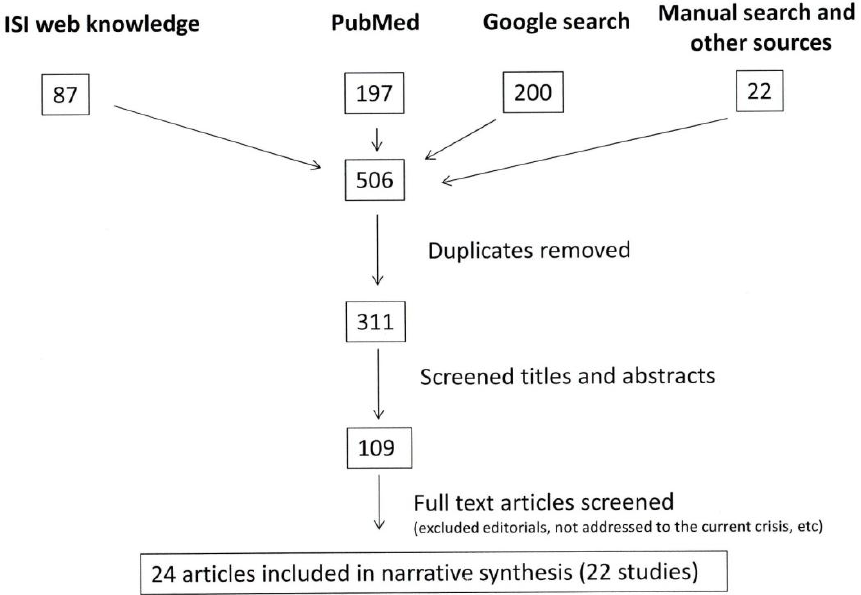
Figure 1. Flow chart of the study selection